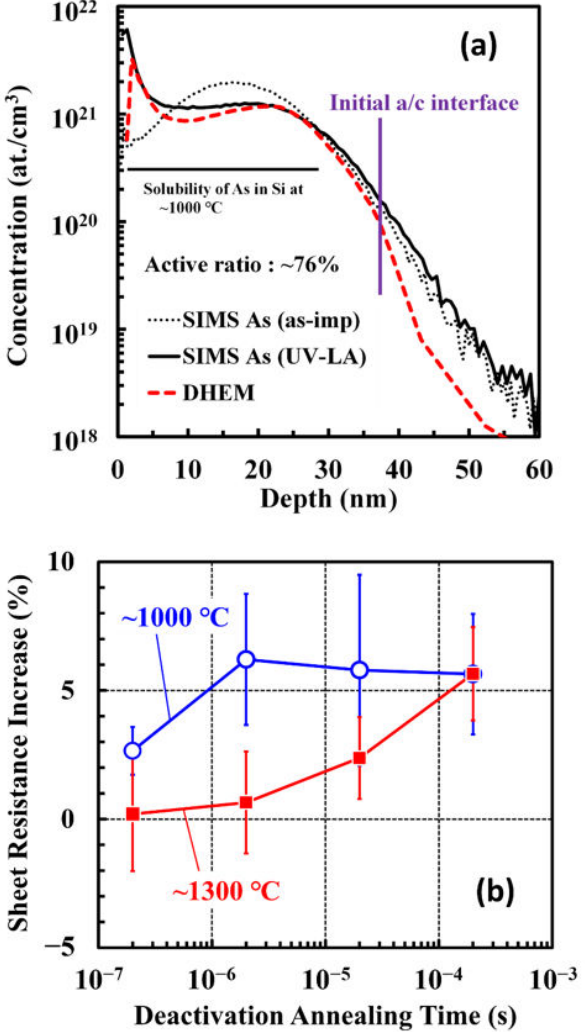
Figure 11. ( a ) SIMS and differential Hall effect methodology (DHEM) profiles taken after µ s UV-LA SPER. The initial a / c interface position and the As solid solubility in c -Si at ∼ 1000 ◦ C reported in Ref. [60] are also indicated. ( b ) Ratio of sheet resistance degradation as a function of the accumulated deactivation annealing time by using the ns UV-LA processes giving different maximum temperatures. Reprinted/adapted under CC BY 4.0 from Ref. [47]. 2022, T. Tabata et